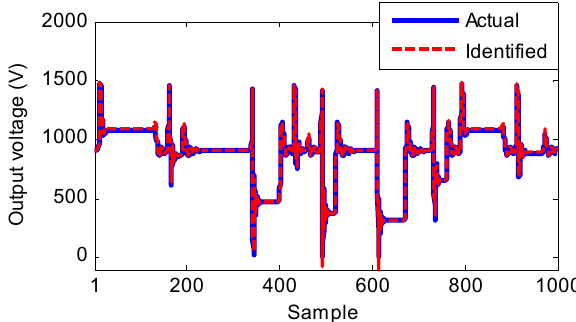
Figure 8. Profile of actual and estimated output voltage for bidirectional converter.